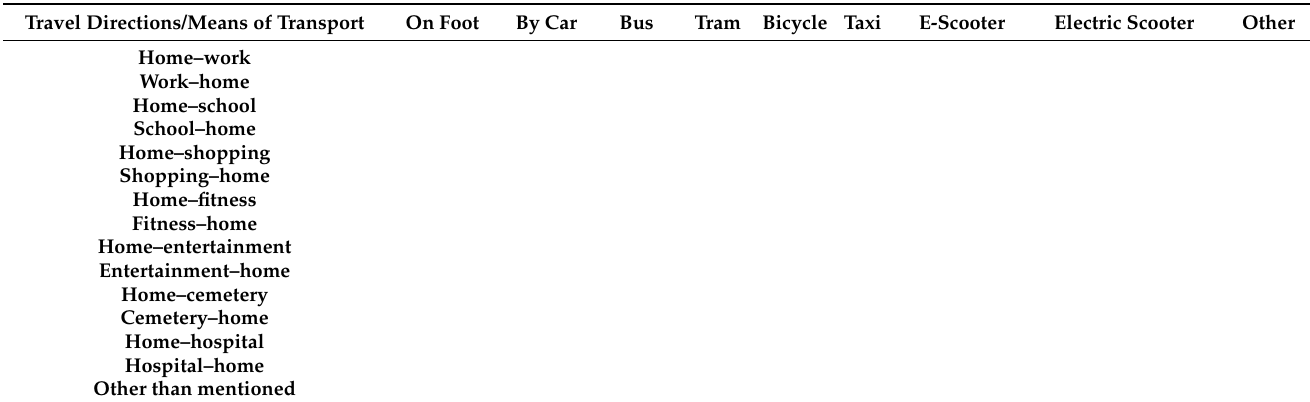
Table 2. The choice of transport in particular